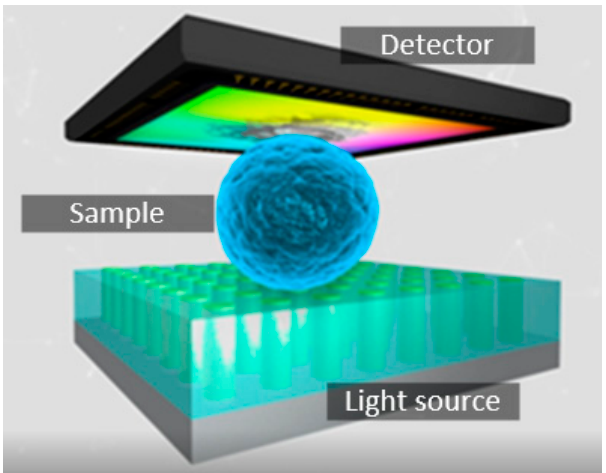
Figure 1. Illustration of the spatial resolved illumination-based scanning optical microscope. The specimen lying on the nanoLED chip surface is scanned, while the projected shadow intensity is recorded.